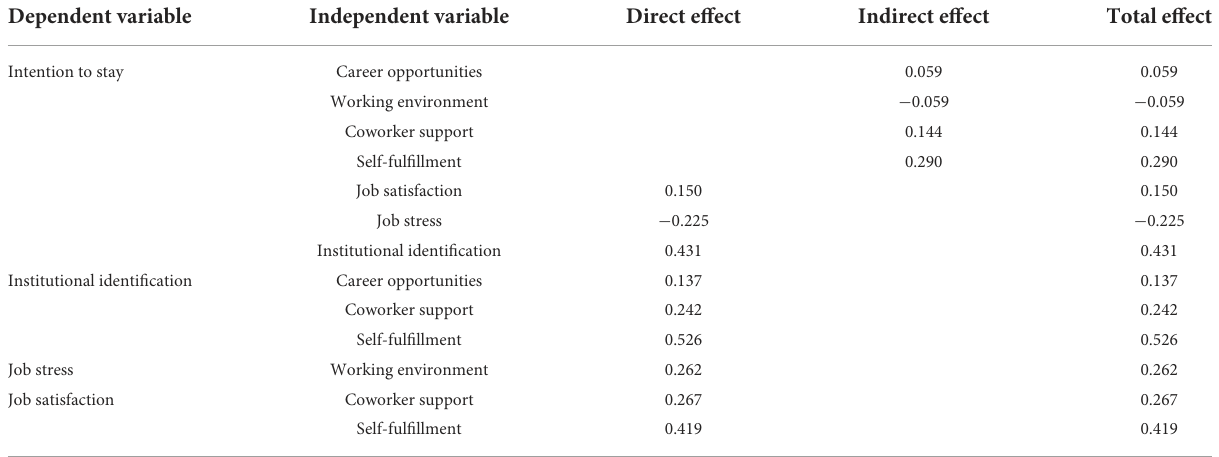
TABLE 7 Path analysis result—direct and indirect